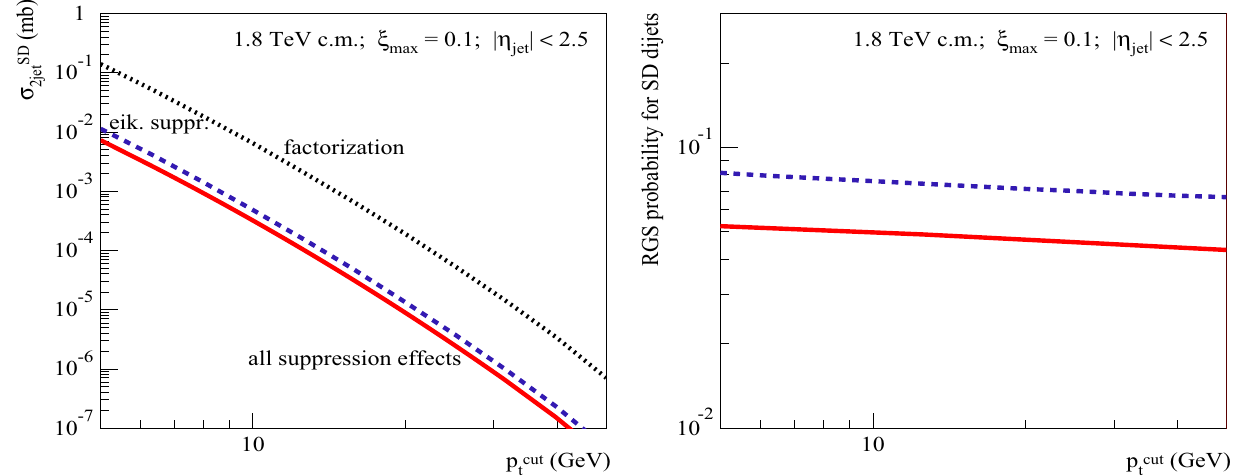
σ 2jet − SD ( fact ) σ 2jet − SD ( eik ) σ 2jet − SD pp (dotted), pp (dashed), and pp (solid). Right: √ S 2 s = 1 . 8 TeV, ξ max = 0 . 1, and | η jet | < 2 . 5 (dashed) and S 2 (solid). All for SD ( eik ) SD ( tot )